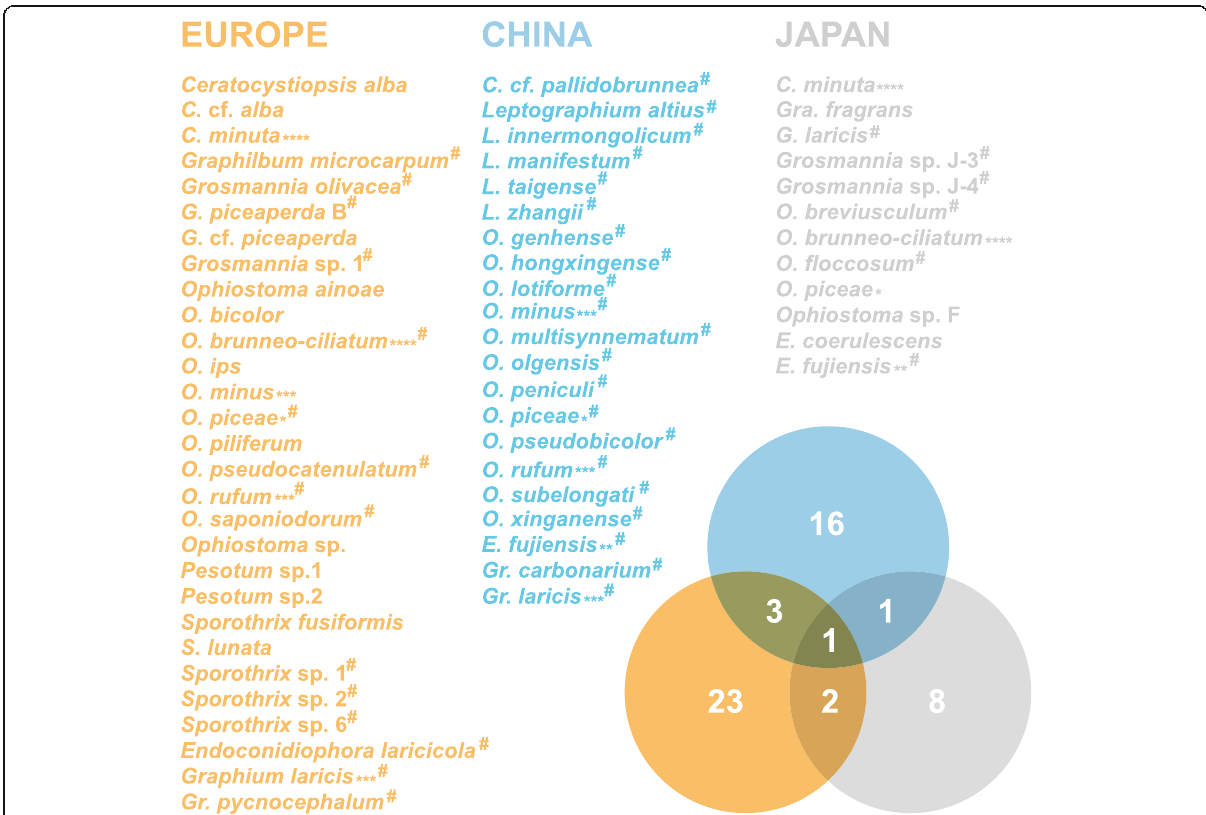
Fig. 20 Venn diagram showing overlaps of the ophiostomatoid fungal communities associated with Ips cembrae in Europe and I. subelongatus in China and Japan* species common to all three regions; ** species common to both China and Japan; *** species common to both China and Europe; **** species common to both Europe and Japan; # species identity confirmed by molecular